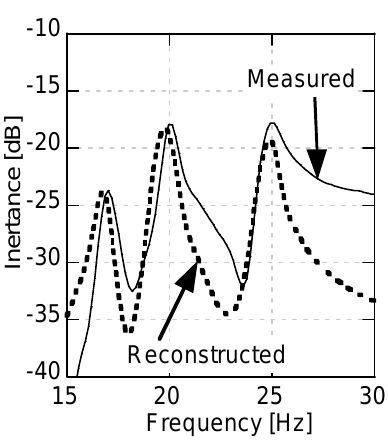
Fig. 18. Vehicle B, RE-FF, FRF of point